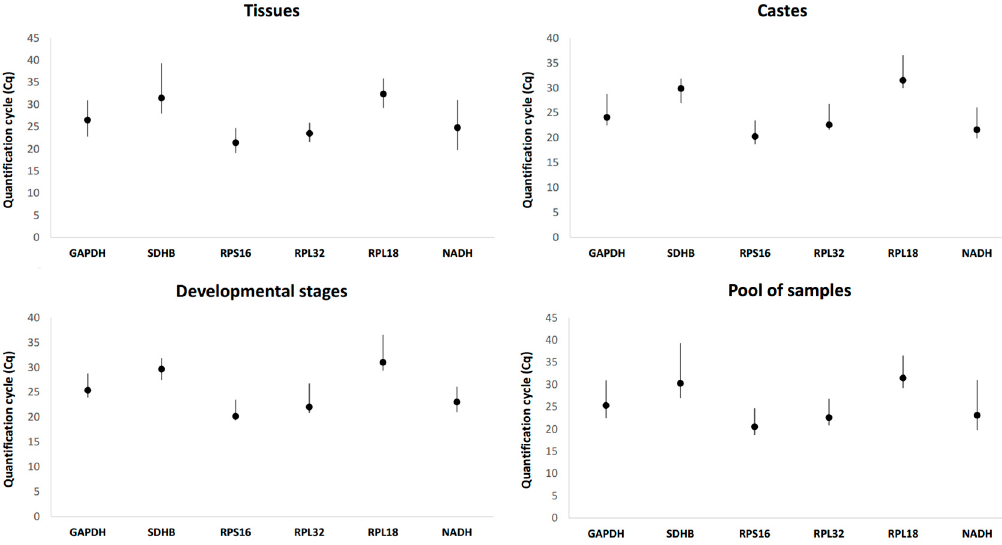
Figure 1. Expression of candidate reference genes as determined by the quantification cycle ( Cq ) values determined in four sample sets. Bars indicate maximum and minimum Cq values while circles represent mean values.